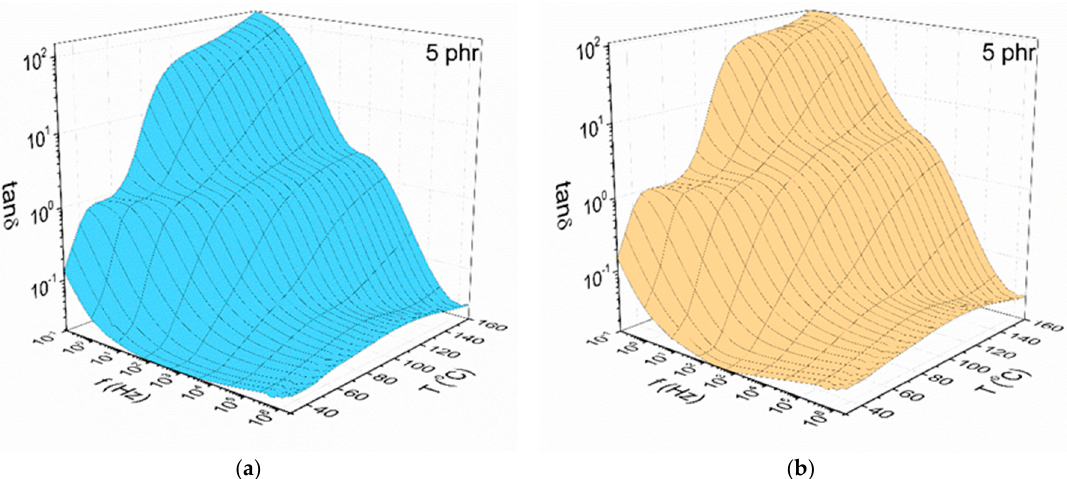
Figure 4. The variation of the loss tangent as a function of frequency and temperature for the nanocomposites with 5 phr: ( a ) BaFe 12 O 19 ; ( b ) SrFe 12 O 19 filler content. nanocomposites with 5 phr: ( a ) BaFe 12 O 19 ; ( b ) SrFe 12 O 19 filler